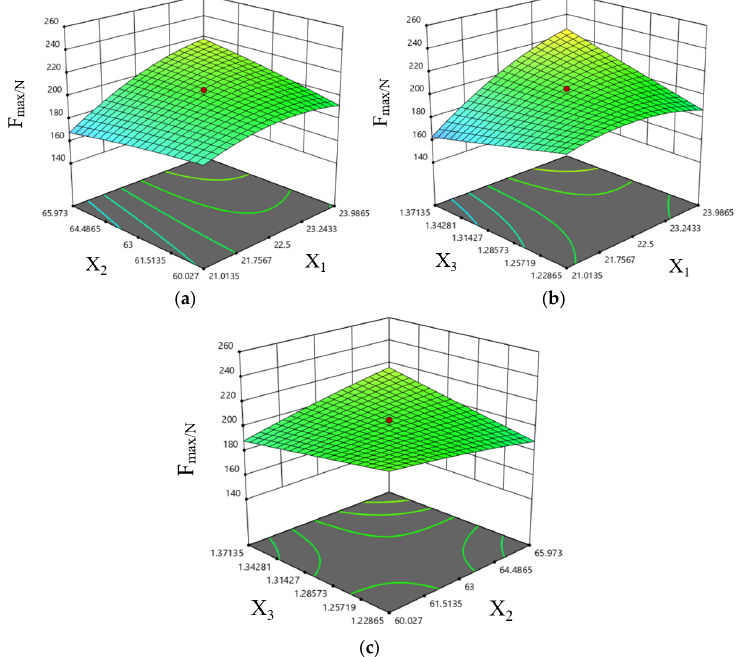
Figure 11. Effect of interaction on maximum shear force: ( a ) the interaction between the cutting-edge angle and the cutting angle on the maximum shear force, ( b ) the interaction between the cutting-edge angle and the reciprocating speed on the maximum shear force, and ( c ) the interaction between the cutting angle and the reciprocating speed on the maximum shear force.